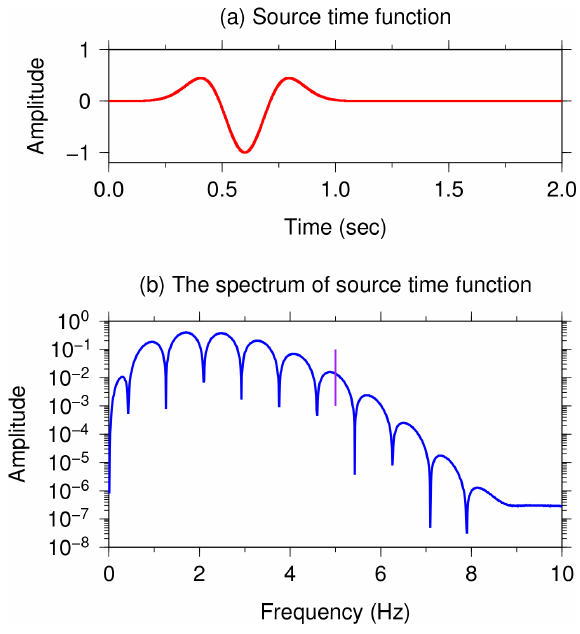
Figure 3. Panel (a) shows source time function Eq. (5) with unit am- plitude A = 1 . 0 and dominant frequency f 0 = 2 . 0. Panel (b) shows frequency spectrum for the source time function in (a) . The purple line is at